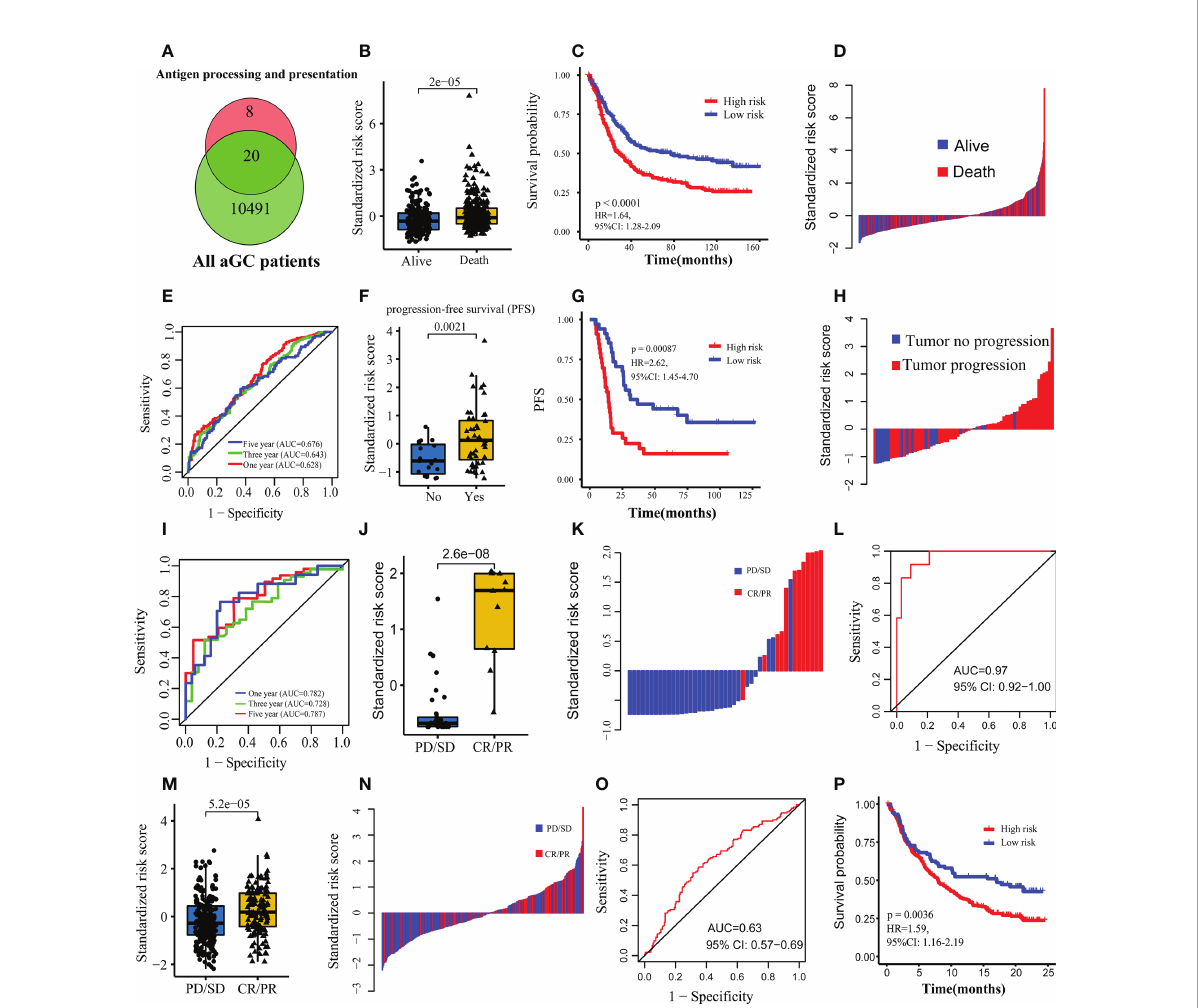
FIGURE 5 Construction and validation of the predictive model for prognosis and immunotherapy response. (A) Venn map showing hub genes used to construct the predictive model. (B) Comparison of the standardized risk score between dead and alive patients in FMAC. (C) The Kaplan-Meier survival curves between the high-risk and low-risk patients in FMAC. (D) Standardized risk score distribution plot in FMAC. (E) ROC for the risk score predicting prognosis in FMAC. (F) Comparison of the standardized risk score between tumor progression and tumor progression-free patients in the GSE26253 dataset. (G) The Kaplan-Meier progression-free survival (PFS) curves between high-risk and low-risk patients in GSE26253 dataset. (H) Standardized risk score distribution plot in GSE26253 dataset. (I) ROC for the risk score predicting prognosis in GSE26253 dataset. (J) Comparison of the standardized risk score between patients with immunotherapy response and patients without immunotherapy response in the Kim cohort. (K) Standardized risk score distribution plot in the Kim cohort. (L) ROC for the risk score predicting immunotherapy response in the Kim cohort. (M) Comparison of the standardized risk score between patients with immunotherapy response and patients without immunotherapy response in the IMvigor210 cohort. (N) Standardized risk score distribution plot in the IMvigor210 cohort. (O) ROC for the risk score predicting immunotherapy response in the IMvigor210 cohort. (P) The Kaplan-Meier survival curves between the high-risk and low-risk patients in the IMvigor210